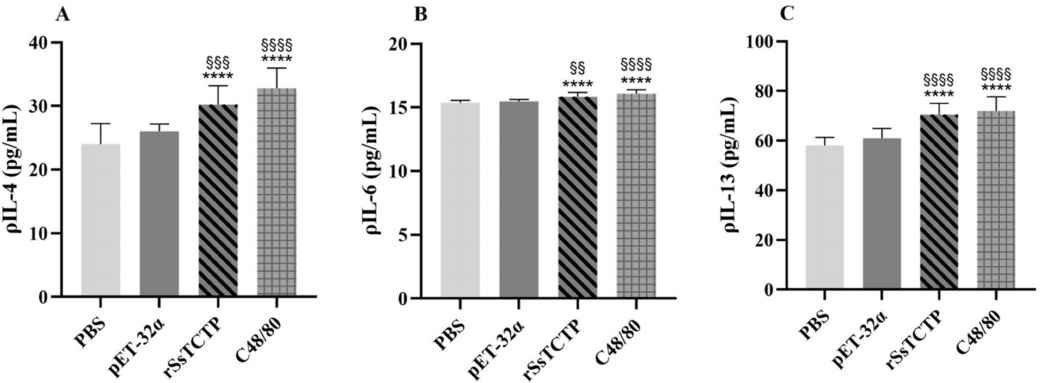
Figure 7. Release of interleukin (IL)-4 ( A ), IL-6 ( B ), and IL-13 ( C ) from KU812 cells. Data from three individual experiments (each experiment had five replicates) are shown as the means ± the standard deviation (SD). **** p < 0.0001 versus PBS group; §§ p < 0.01, §§§ p < 0.001, §§§§ p < 0.0001 versus pET-32 α group ( t -test). rSsTCTP, recombinant Sarcoptes scabiei translationally controlled tumor